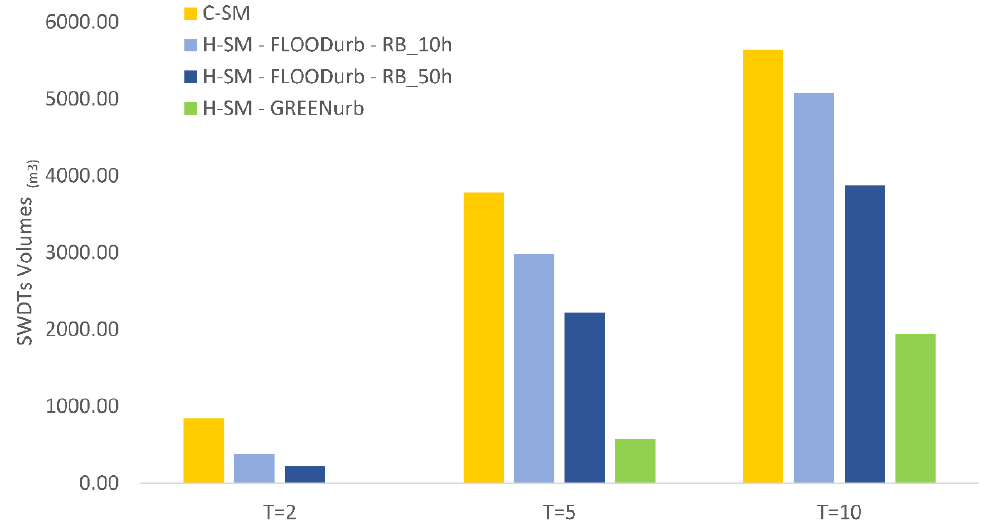
Figure 8. Stormwater detention tanks total volumes: a comparison between the investigated C-SM and H-SM scenarios.